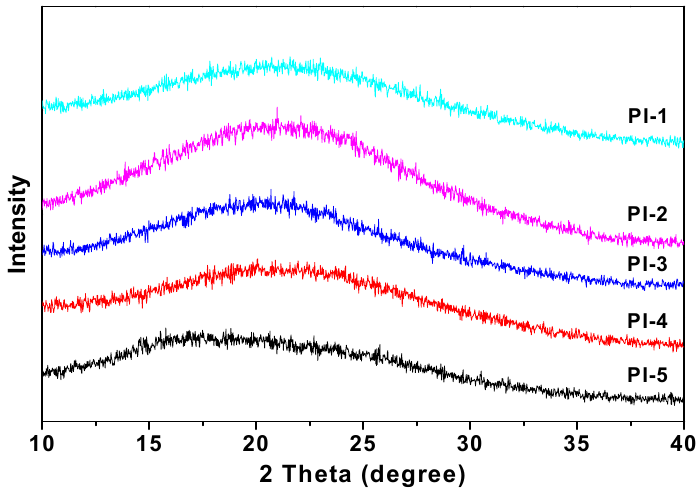
Figure 6. WAXD patterns of the polyimides.